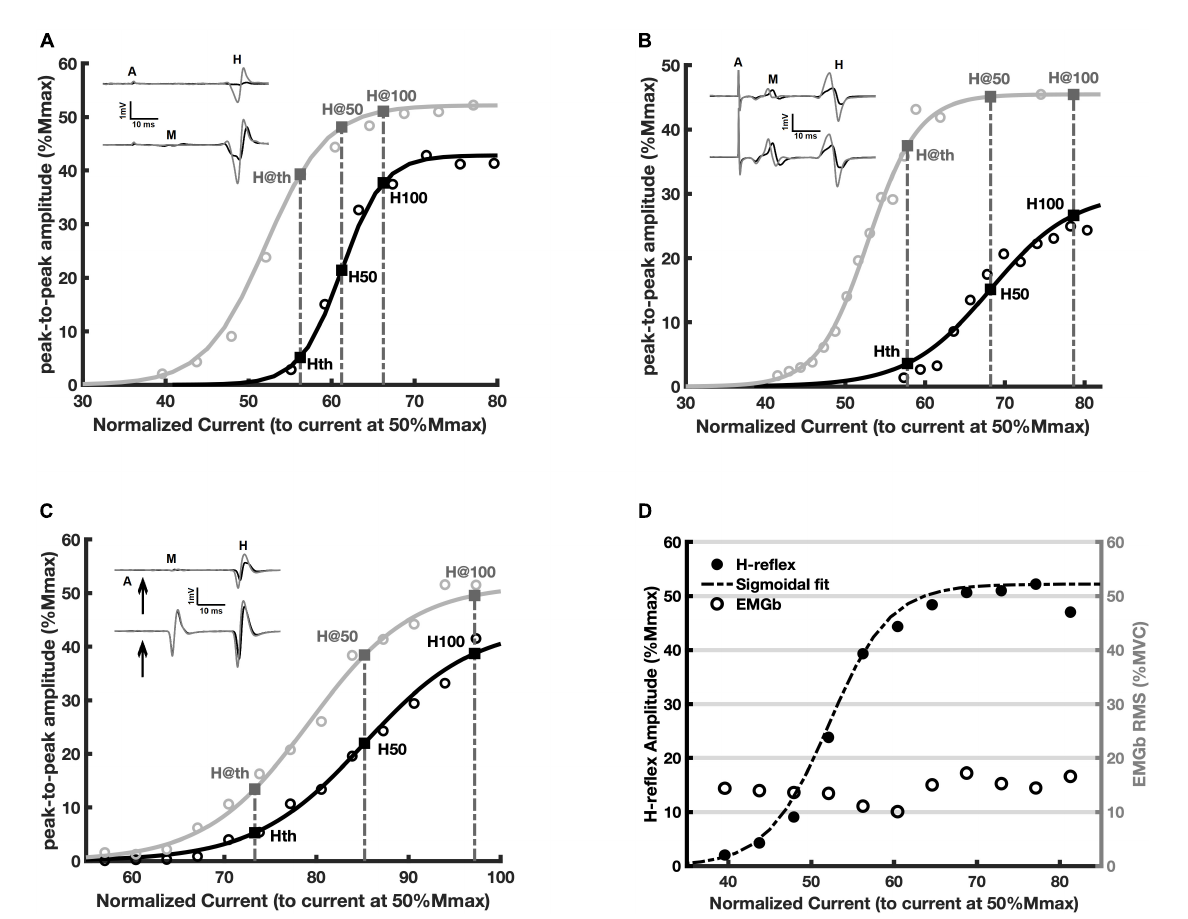
FIGURE3 Recruitment curves (RCs) and the respective amplitude parameters obtained at rest (black) and during voluntary contraction (gray). Each circle is the averaged value of five measurements (see Methods). The continuous lines are the fitted curve. (A) Representative adult young participant; (B) representative elderly participant; (C) data from the simulation; (D) the same data as in panel (A) (filled black circles are the peak-to-peak H-reflex amplitudes), along with the respective EMGb (open